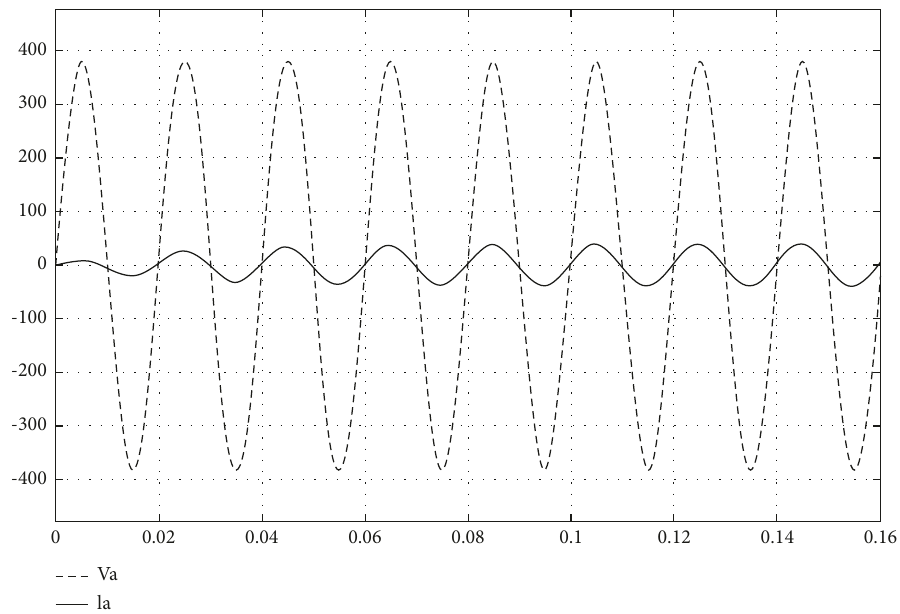
Figure 10: Input voltage and current waveform when the conduction angle of H-bridge is